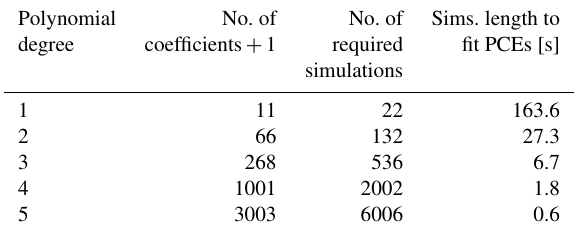
Table 1. The number of coefficients and required data points to cal- culate the coefficients for 10 random variables and using the point collocation method. This number of coefficients should be calcu- lated for every time step. The last column demonstrates the simula- tion (sims) length for the fitted PCEs as explained in Sect.